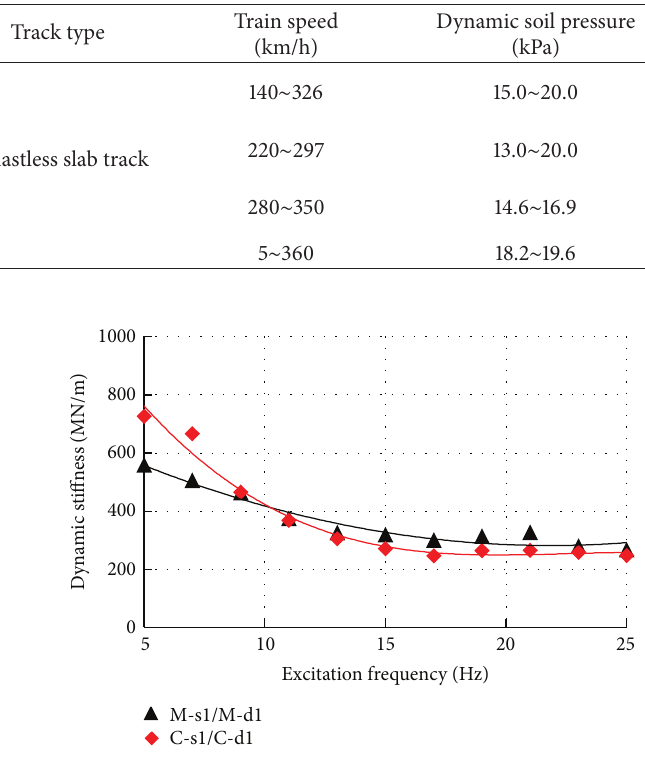
Figure 13: Dynamic stiffness of the subgrade versus vibration